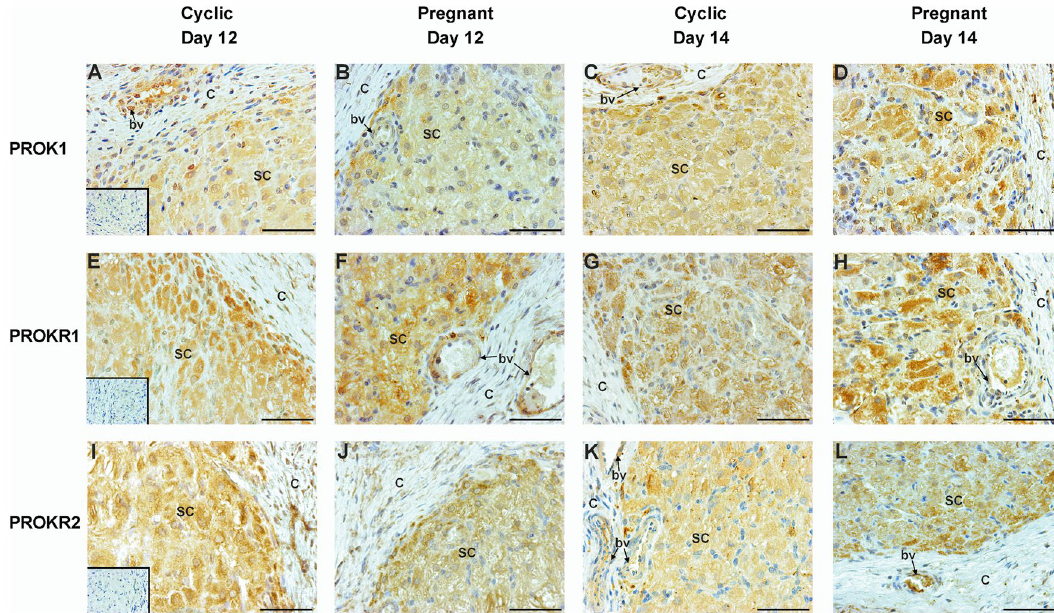
Figure 2. Immunolocalization of prokineticin 1 (PROK1; A – D ), prokineticin receptor 1 (PROKR1; E – H ), and 2 (PROKR2; I – L ) in the porcine corpora lutea on Day 12 ( A , B , E , F , I , and J ) and 14 ( C , D , G , H , K , and L ) of the estrous cycle ( A , C , E , G , I , and K ) and pregnancy ( B , D , F , H , J , and L ). Positive signals of all studied proteins were detected in luteal steroidogenic cells (SC), and endothelial cells that forms blood vessels (“bv” with arrow). A week signal or no signal is shown in theca derived luteal capsule ( C ). All sections were counterstained with hematoxylin. The negative control is presented in the down-left corners of A, I (Normal rabbit IgG), and E panels (antibodies with the blocking peptide). Scale bar represents 50